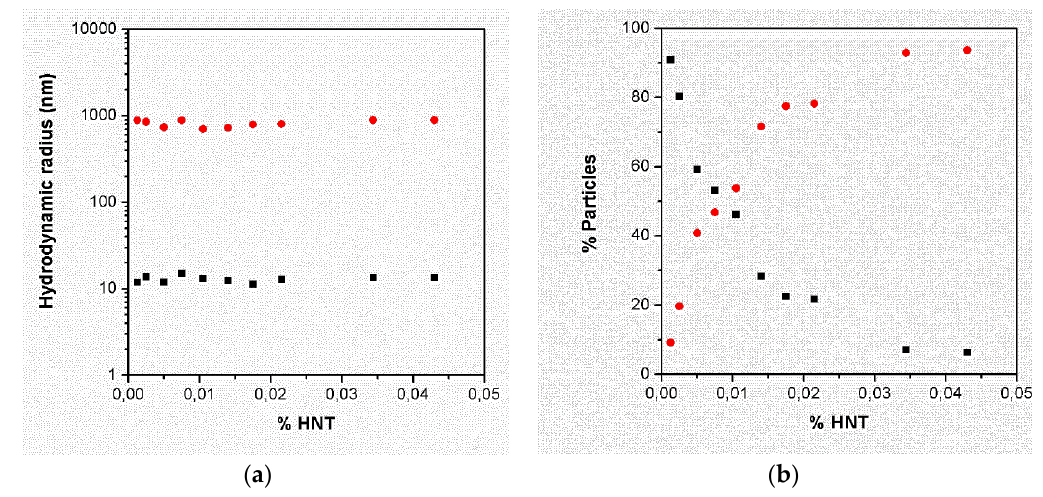
Figure 3. ( a ) Hydrodynamic radius of HNT (red circles) and microemulsion (black squares). ( b ) % of particles from DLS intensity for microemulsion (black squares) and HNT (red circles) particles.